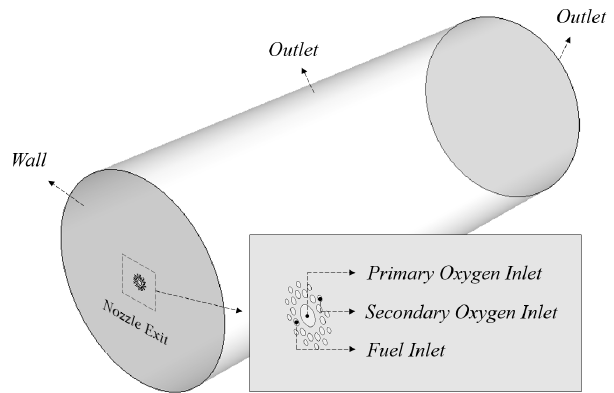
Figure 2. 3D computational domain of the supersonic coherent jet modeling.